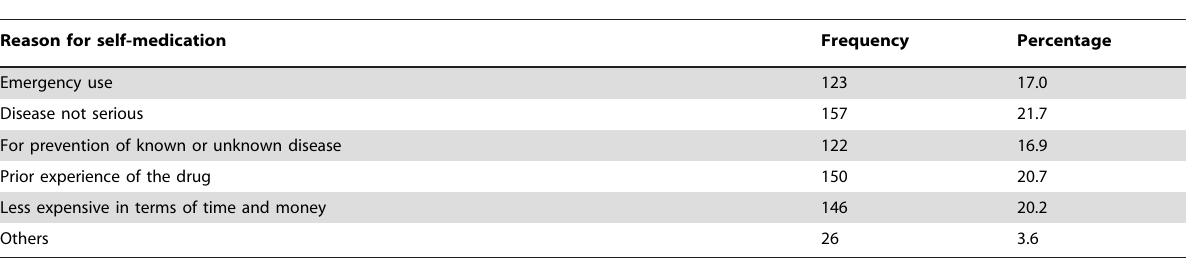
Table 2. Reasons for self-medication (n=